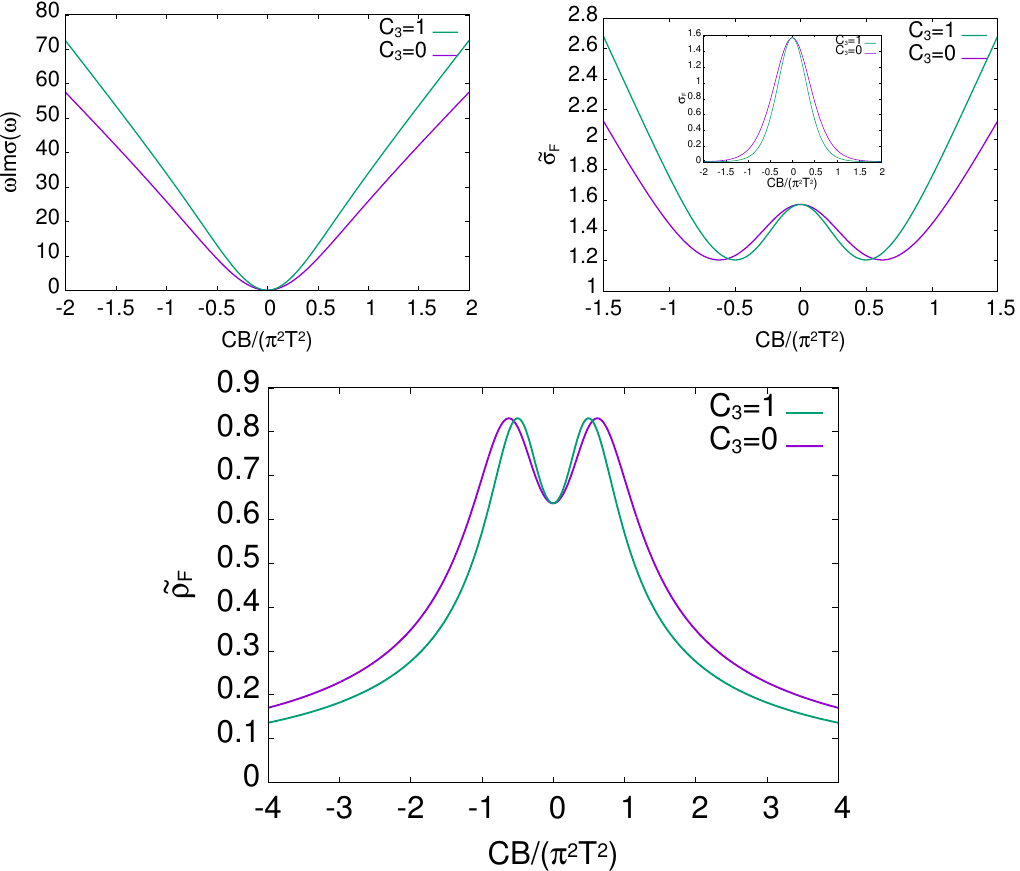
Figure 2 . The dependence of the ! Im (cid:27) ( ! ) (upper left panel) and the real part of the DC conduc- tivity ~ (cid:27) F ( ! = 0) (upper right panel) on CB , with C = C 1 being a chiral anomaly parameter. The (cid:25) 2 T 2 conductivity has been calculated from the relation (4.33) for a holographic system with action (3.1). We used the relation C i = 8 (cid:11) i = 3 between anomaly parameters C i in the hydrodynamic approach and corresponding parameters (cid:11) i adopted in (3.1). One of the two curves in each panel is obtained for all C i 6 = 0 (denoted C 3 = 1), while the other for C 1 = C = 1 and C 3 = 0 (denoted C 3 = 0). The existence of Z 2 topological charge (corresponding to C 3 = 1 = C 2 = C 4 = C 1 and shown by the upper curve in the upper panel) leads to the narrowing of the magneto-conductivity. To obtain the magnetoconductivity shown in the upper right panel we have assumed that T = 1, (cid:28) e = 0 : 05 and ! = 0. The inset shows the Boltzmann part (cid:27) F . The lower panel of the (cid:12)gure shows the magnetoresistance of the same